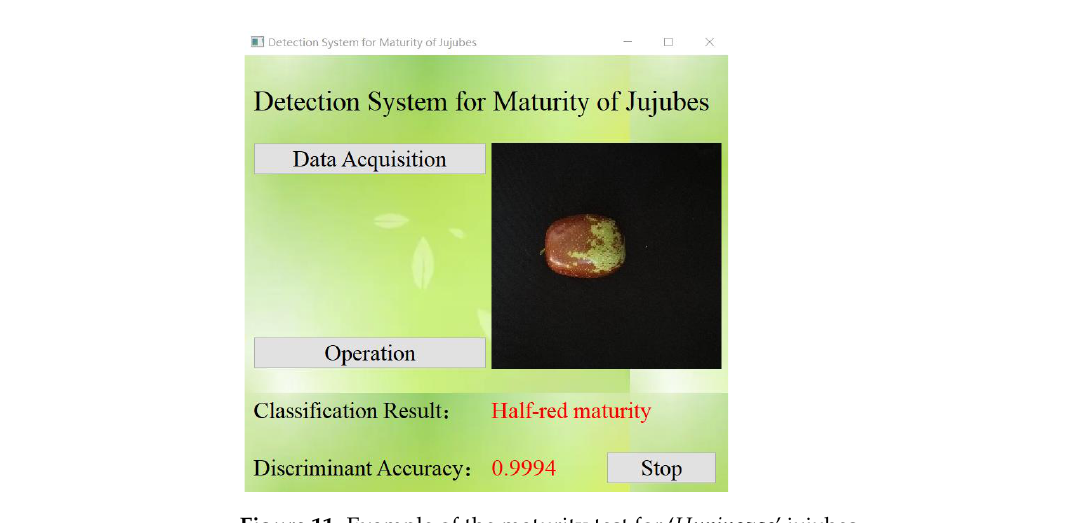
Figure 11. Example of the maturity test for ‘ Hupingzao ’ jujubes. Table 6. Test results for samples of different maturity levels.